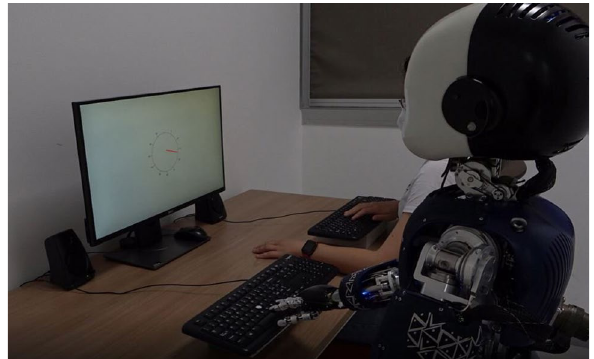
Figure 1. Experimental